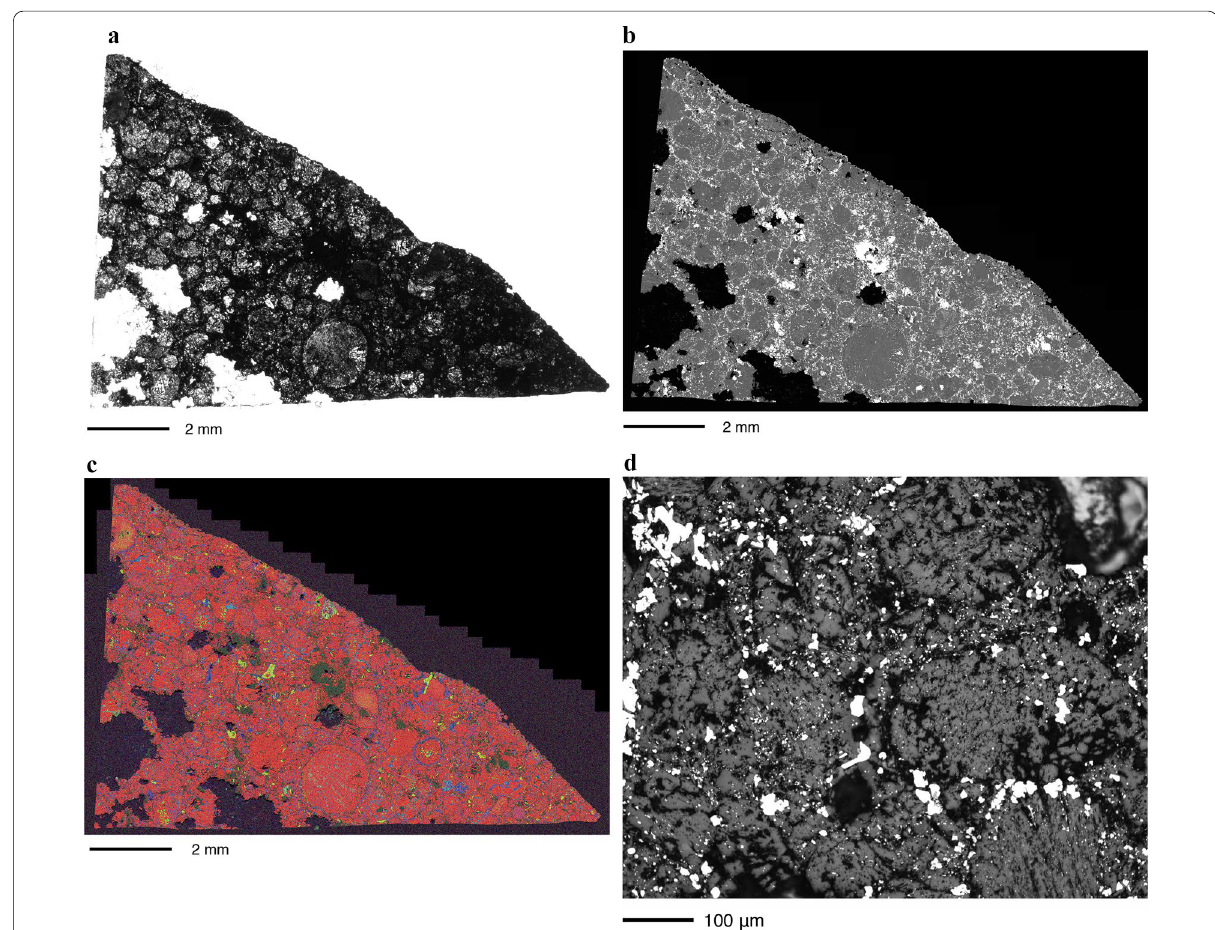
Fig. 1 a Photomicrograph (transmitted plane-polarized light) of a thin section of MS-177 containing abundant sharply bounded chondrules. The section shows a darkened appearance. b Backscattered electron (BSE) image of the MS-177 section showing abundant spherical chondrules (dark) with well-defined outlines. Opaque minerals (mainly Fe–Ni metal and troilite) (bright) are abundant in MS-177. c Combined elemental map in Mg (red), Ca (green), and Al (blue) showing a high abundance of diopside (light green) in chondrules and as isolated minerals. d Reflected light photomicrograph of a part of MS-177 containing chondrules and isolated minerals. Fine-grained Fe–Ni metal and troilite (bright grains) are abundantly distributed in silicate minerals resulting in the darkened